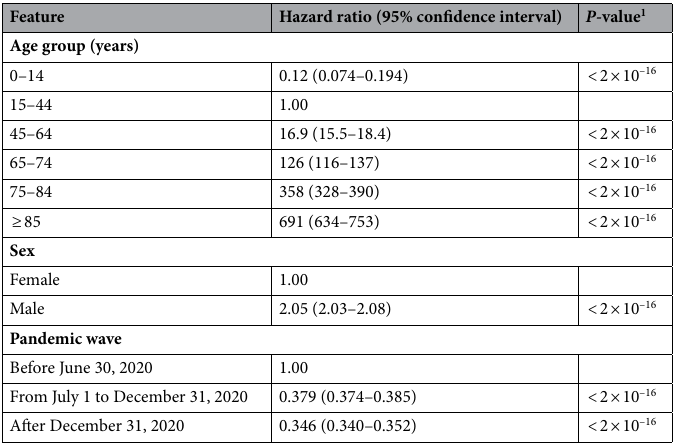
Table 2. Factors associated with death in the whole Italian series of people infected by SARS-CoV-2. Of the entire series, 108,316 cases were excluded due to incomplete or erroneous data, for a total of 4,224,698 SARS- CoV-2-positive subjects analyzed and 109,605 deaths within 30 days of diagnosis. 1 Multivariable weighted Cox analysis (non-proportional hazards model).